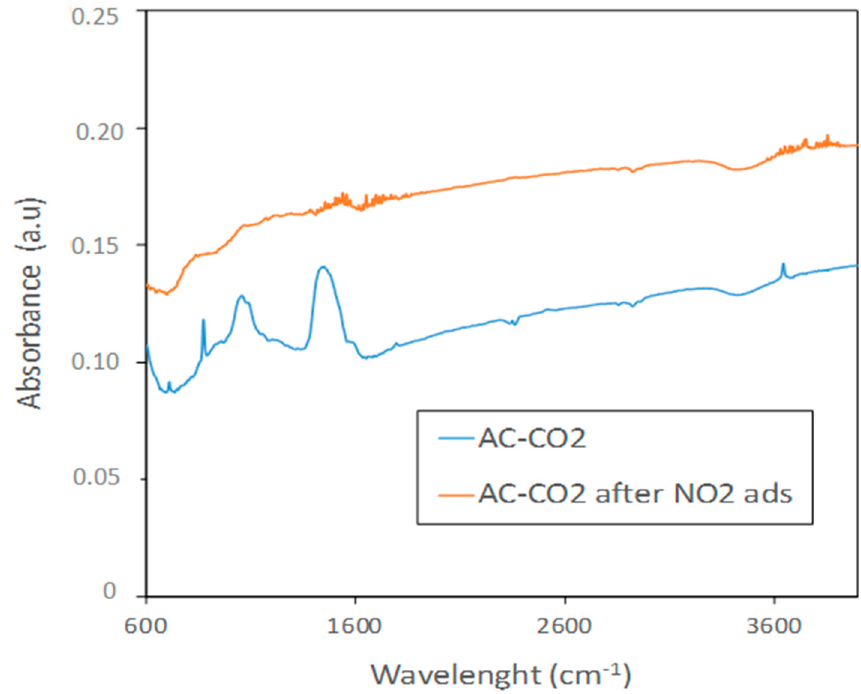
Figure 10. FTIR spectra of the AC-CO 2 sample before and after NO 2 adsorption.